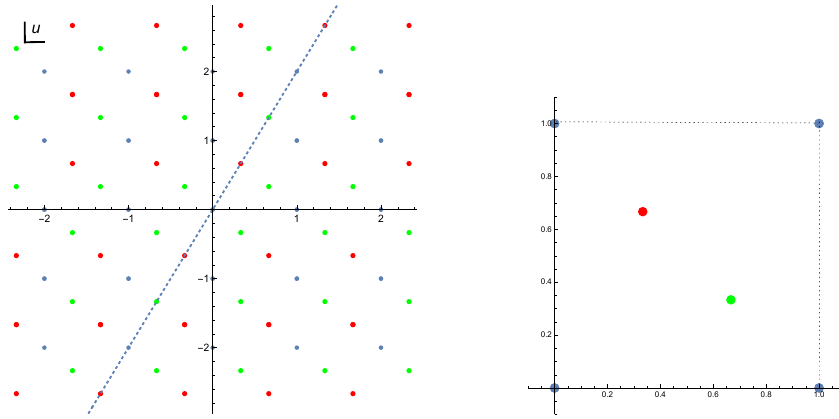
Figure 9 . The zeroes and singular points of Q . Blue points are zeroes of the vector multiplet contribution. Red and green points are singularities of the chiral multiplet contributions. The red ones are singularities of the undressed elliptic Gamma functions, while the green ones are singularities that come from the dressing factor P ( z ) z 2 in equation (3.7) (see also (3.21)). Both singularities are of order one and the zeroes are of order two. The horizontal unit stands for 1 and the vertical unit stands for (cid:28)